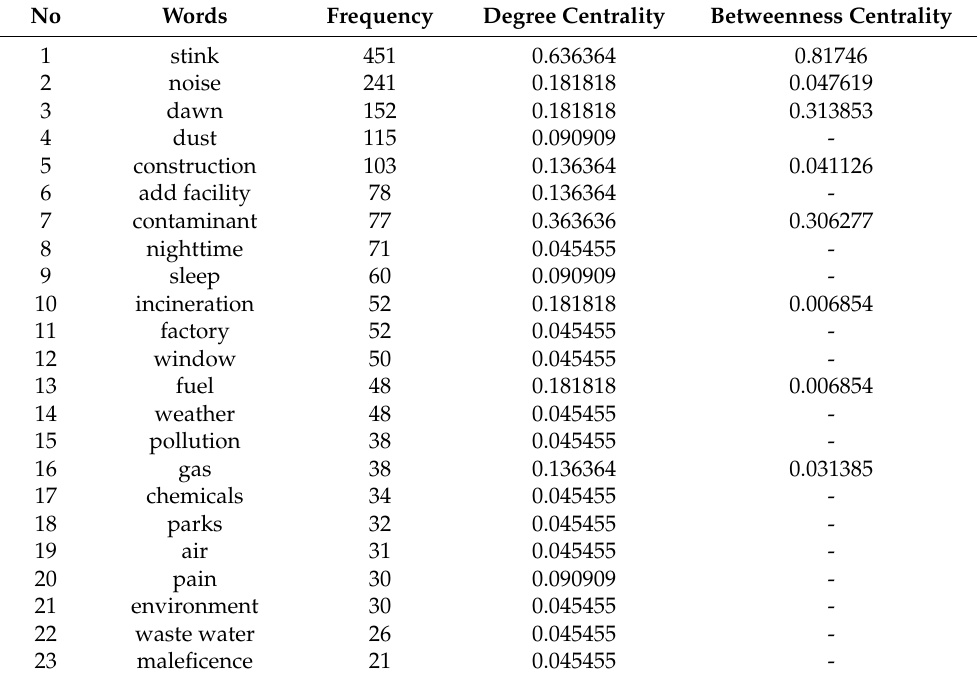
Table 3. The frequency and the centrality value of degree and betweenness of each word in